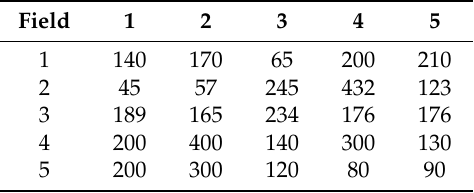
Table 6. Average population along connections of fields to collecting centers (people/km).